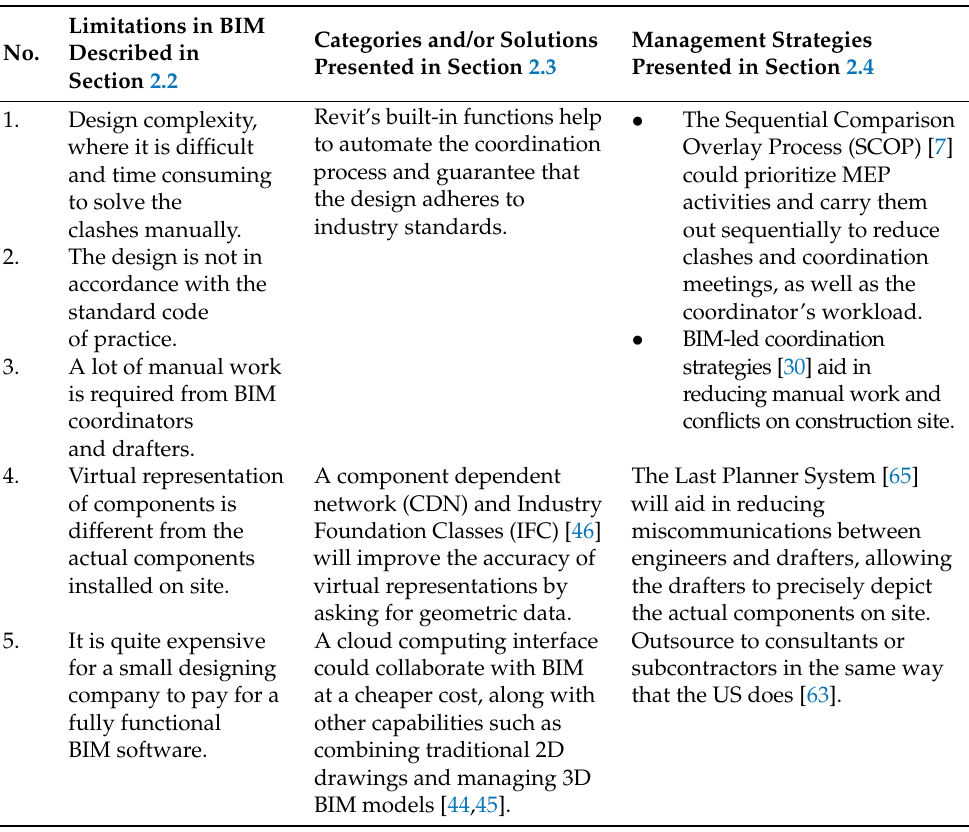
Table 2. Recommendations to solve the limitations stated in Section 2.2 based on the categories and/or solutions presented in Sections 2.3 and